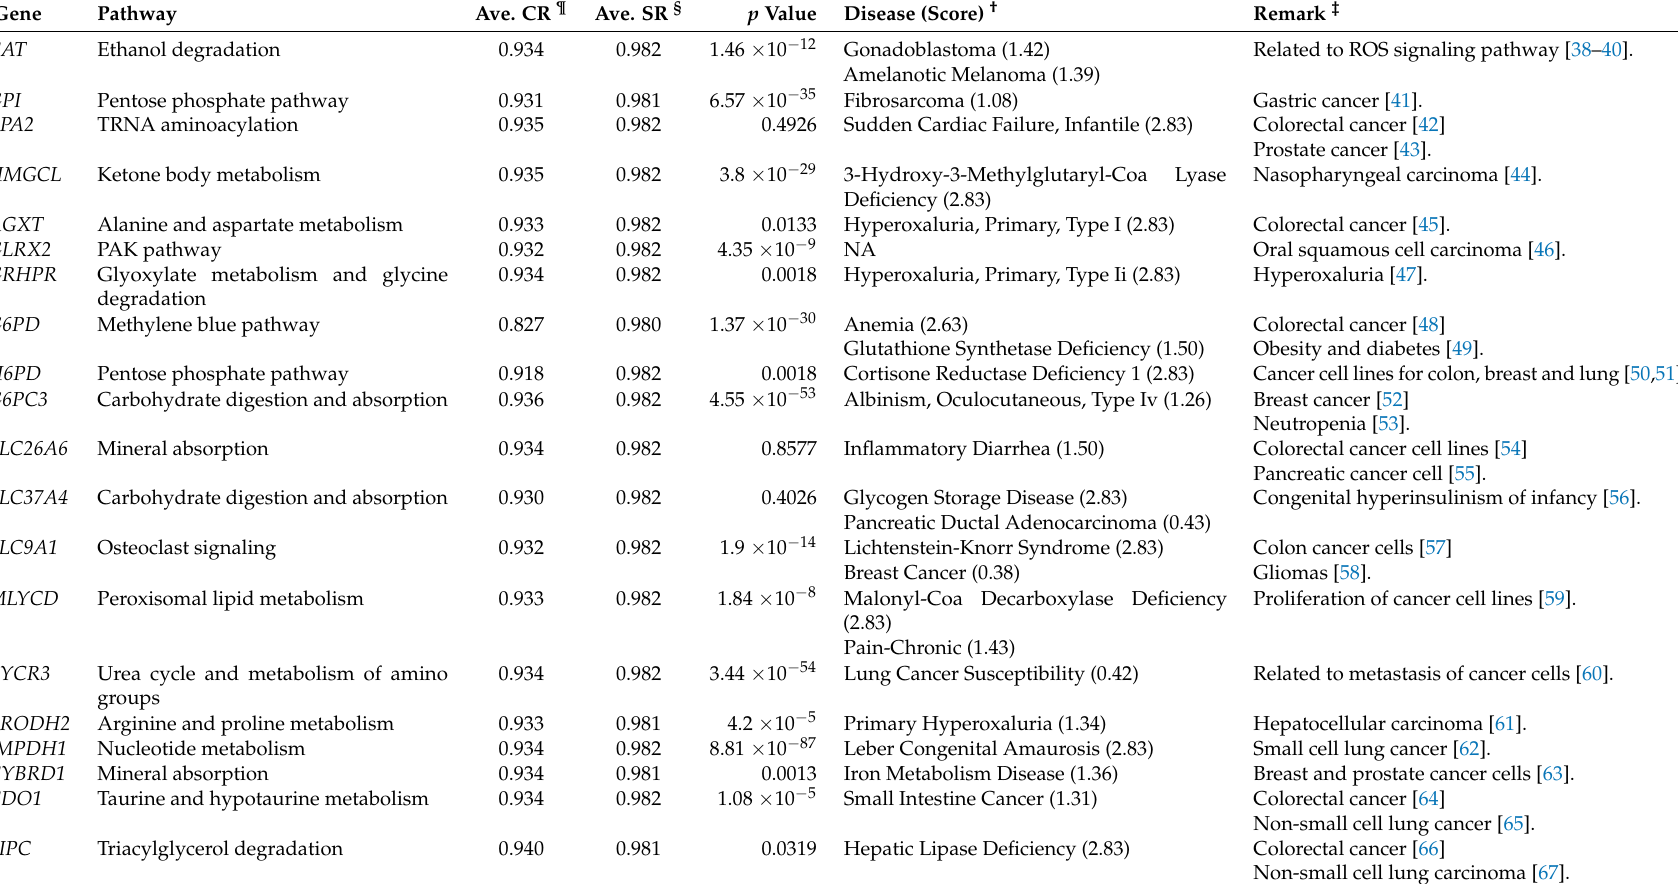
Table 1. Top 20 one-hit